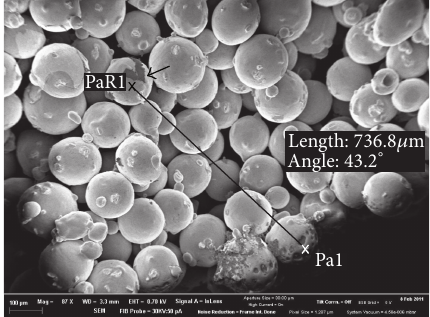
Figure 5: Cell ingrowth. SEM picture from the breaking edge of material “Mix” after 2 days of incubation with SaOs-2 cells. Pa1 is a point on the outer surface; point PaR1 is close to cells inside the material. Arrow points out the